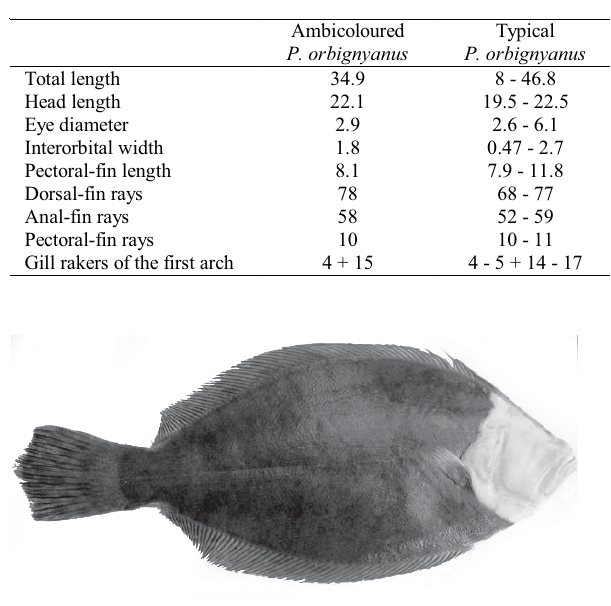
Fig. 1. Blind side of an ambicoloured specimen of Paralichthys orbignyanus caught in the arroyo Pando, Uruguay (ZVCP 6458 - SL 271 mm).